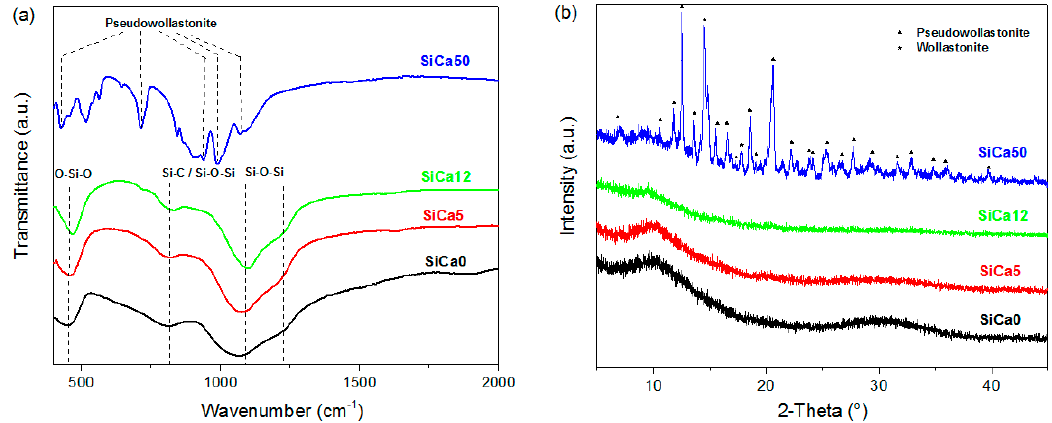
Figure 3. ( a ) FTIR spectra and ( b ) XRD diffractograms of SiCa0, SiCa5, SiCa12, and SiCa50 (samples obtained from corresponding xerogel precursors via pyrolysis at 1100 °C in Ar atmosphere).